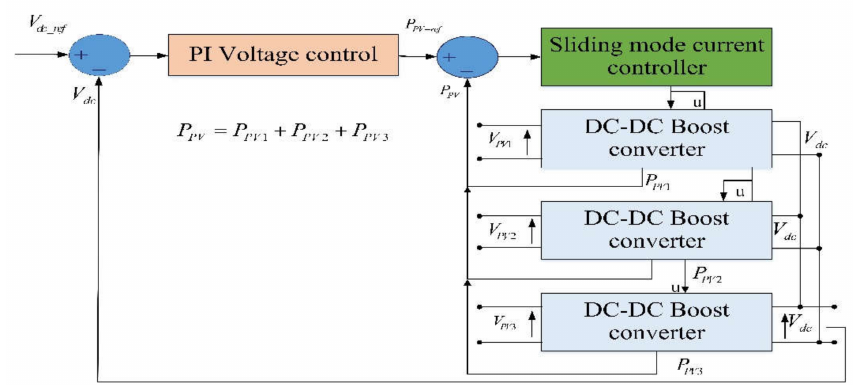
Figure 7. Cascaded PV boost converter